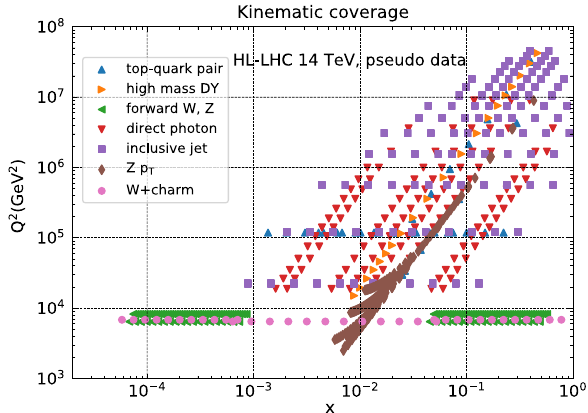
Fig. 2 The kinematical coverage in the ( x , Q 2 ) plane of the HL–LHC pseudo–data included in this analysis. For each data point, the values of ( x 1 , Q 2 ) and ( x 2 , Q 2 ) corresponding to each of the two colliding partons are determined approximatly from the corresponding leading– order kinematics. We assume x 1 = x 2 if rapidities are not specified for thefinalstates.TheHL–LHCpseudo–datathereforespansawideregion in the kinematic plane, namely 6 × 10 − 5 (cid:3) x (cid:3) 0 . 7 and 40 GeV (cid:3) Q (cid:3) 7